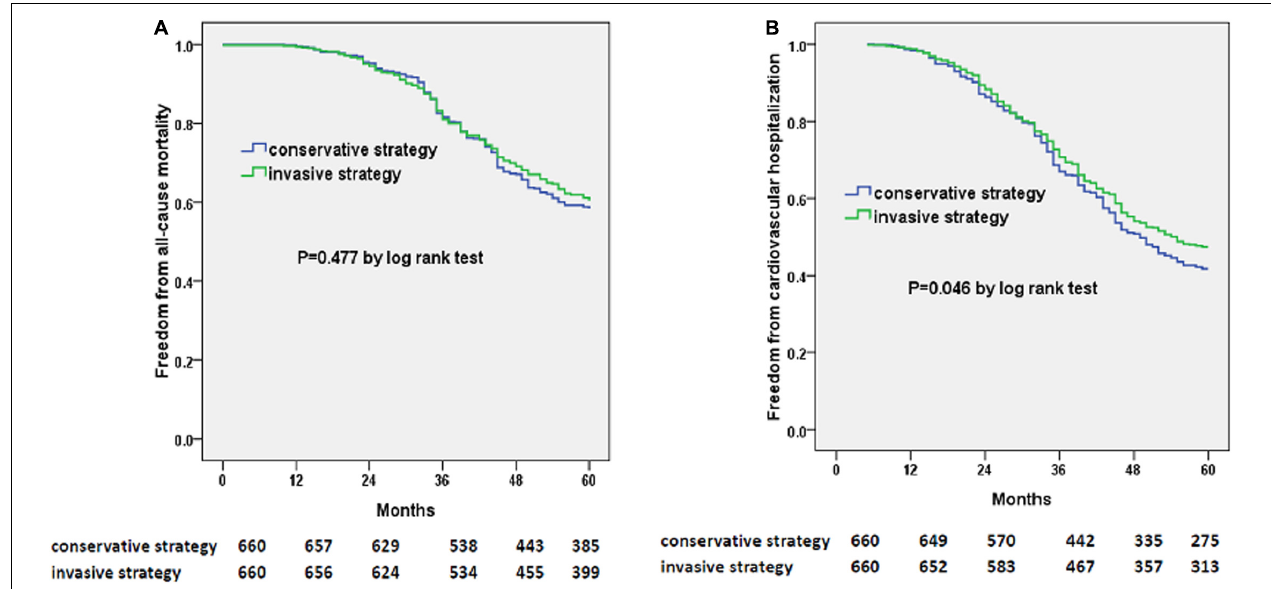
FIGURE 3 | Kaplan–Meier curves of freedom from all-cause mortality (A) and cardiovascular hospitalization (B) . The numbers at the bottom of the figure are “number at risk.”